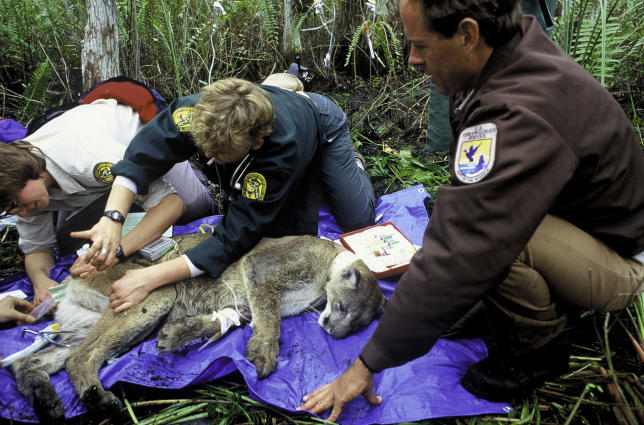
Collecting Valuable Data from a Sedated PantherAfter ensuring a panther has survived the ordeal of treeing and capture unscathed, a team of state and federal wildlife biologists examines the cat and collects samples for laboratory analysis. Cats are also dewormed and vaccinated. A saline drip keeps the animal hydrated while the team collects skin for genetic analysis, hair to measure mercury exposure, and blood to check for diseases. The FWS fears that a recent outbreak of feline leukemia in the Okaloacoochee Slough population could trigger accelerated extinction.(Photo: US Fish and Wildlife Service)